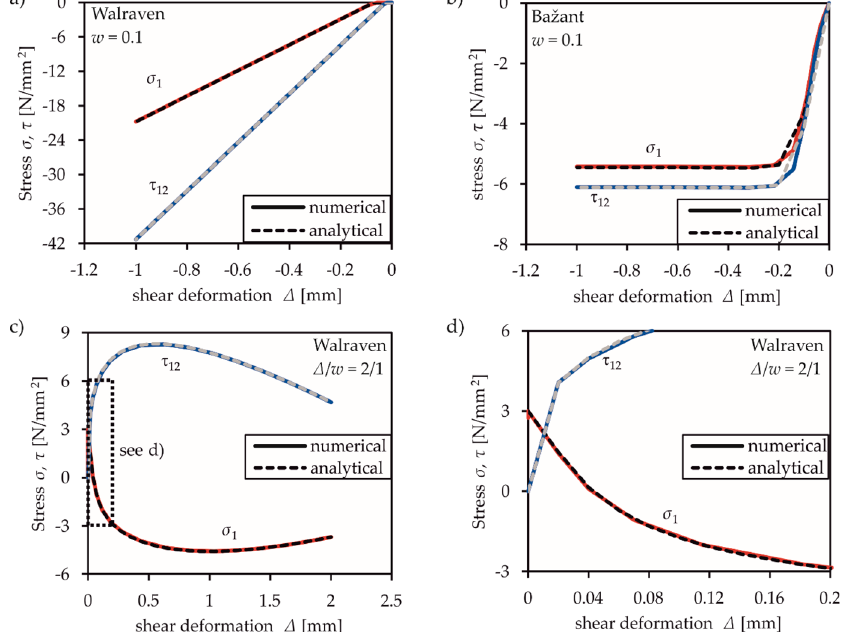
Figure 7. Illustration of numerical verification results compared to a theoretically analytic solution for ( a ) and ( b ) shear with constant crack width and ( c ) and ( d ) constant tension-shear condition., FRCM with Walraven’s or Bažant’s aggregate interlock model.